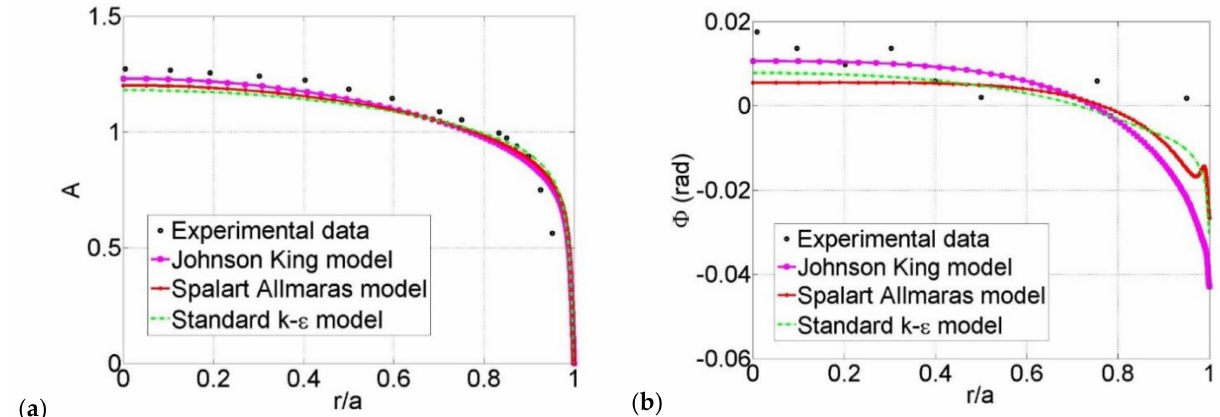
Figure 13. Comparison between the Johnson–King turbulence model and higher-order turbulence models (Case 7: Re o s = 40,600, α = 7.9): ( a ) amplitude ratio; ( b )